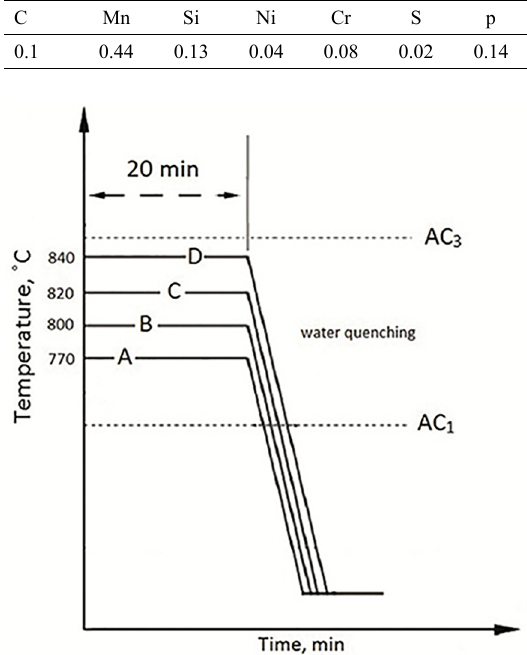
Table 1. Chemical composition of the investigated steel (wt%).